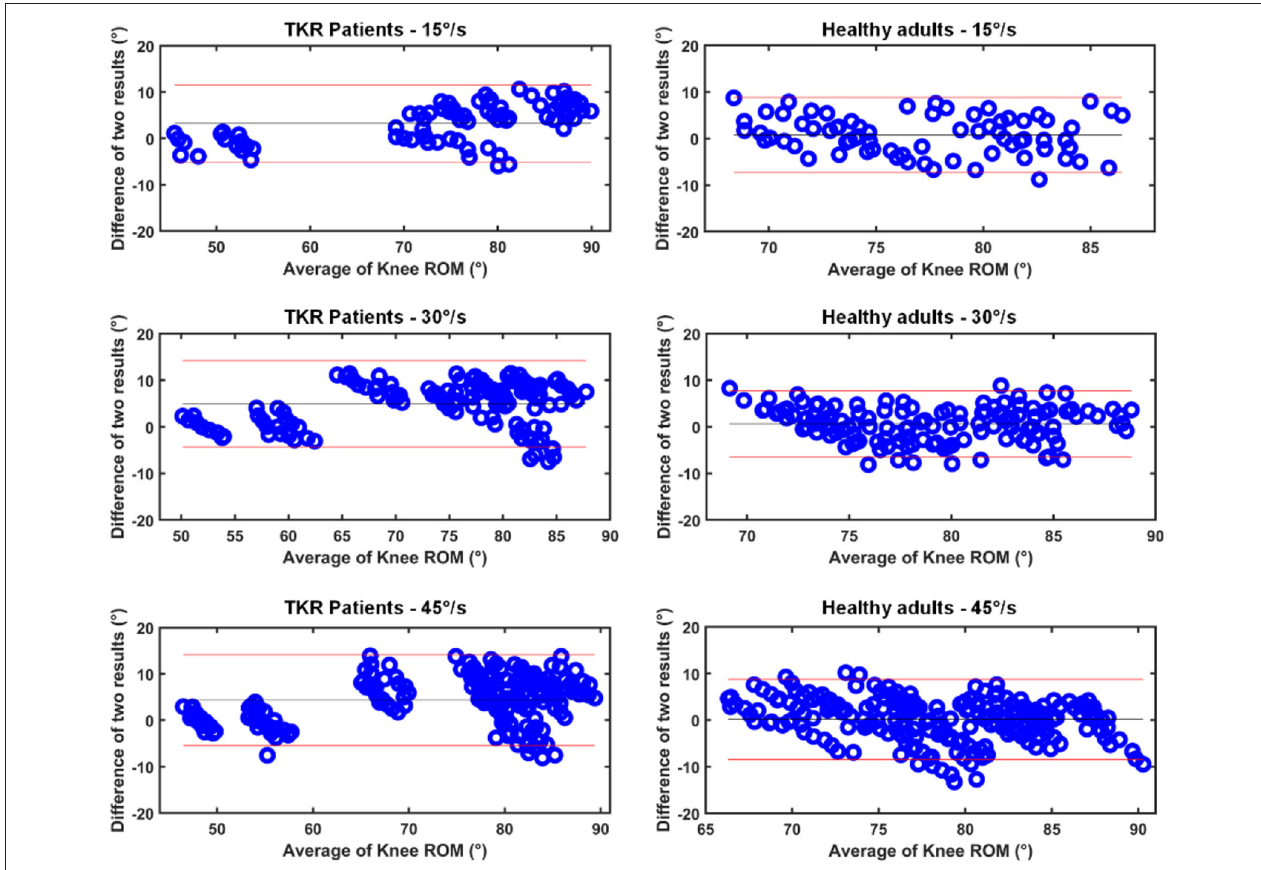
FIGURE 5 | Bland-Altman plot of knee ROM results for two systems. The horizontal axis is the average of the estimates and the vertical axis is the absolute error of the two results.